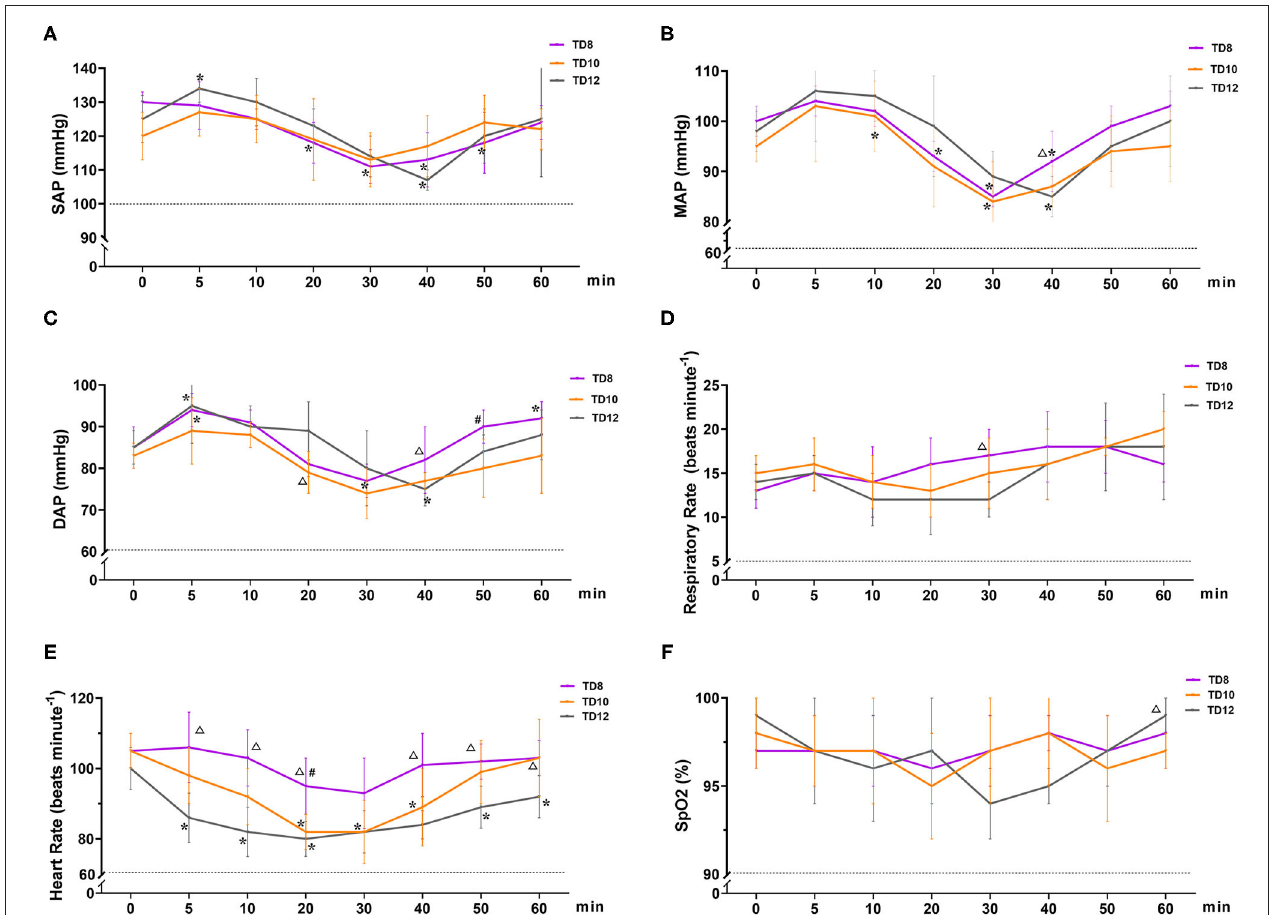
FIGURE 2 | Cardiopulmonary variables in dogs that were administered tiletamine and three concentrations of dexmedetomidine in Phase 1. (A) Systolic arterial pressure (SAP); (B) mean arterial pressure (MAP); (C) diastolic arterial pressure (DAP); (D) respiratory rate ( f R ); (E) heart rate (HR); and (F) peripheral hemoglobin oxygen saturation (SpO 2 ). TD8 group, 4.5mg kg − 1 tiletamine plus 8 µ g kg − 1 dexmedetomidine; TD10 group, 4.5mg kg − 1 tiletamine plus 10 µ g kg − 1 dexmedetomidine; TD12 group, 4.5mg kg − 1 tiletamine plus 12 µ g kg − 1 dexmedetomidine. Values are expressed as mean ± standard deviation (SD). *Significantly different from 0min at the same group ( p < 0.05). # Significantly different from TD10 within the same time ( p < 0.05). 1 Significantly different from TD12 within the same time ( p <